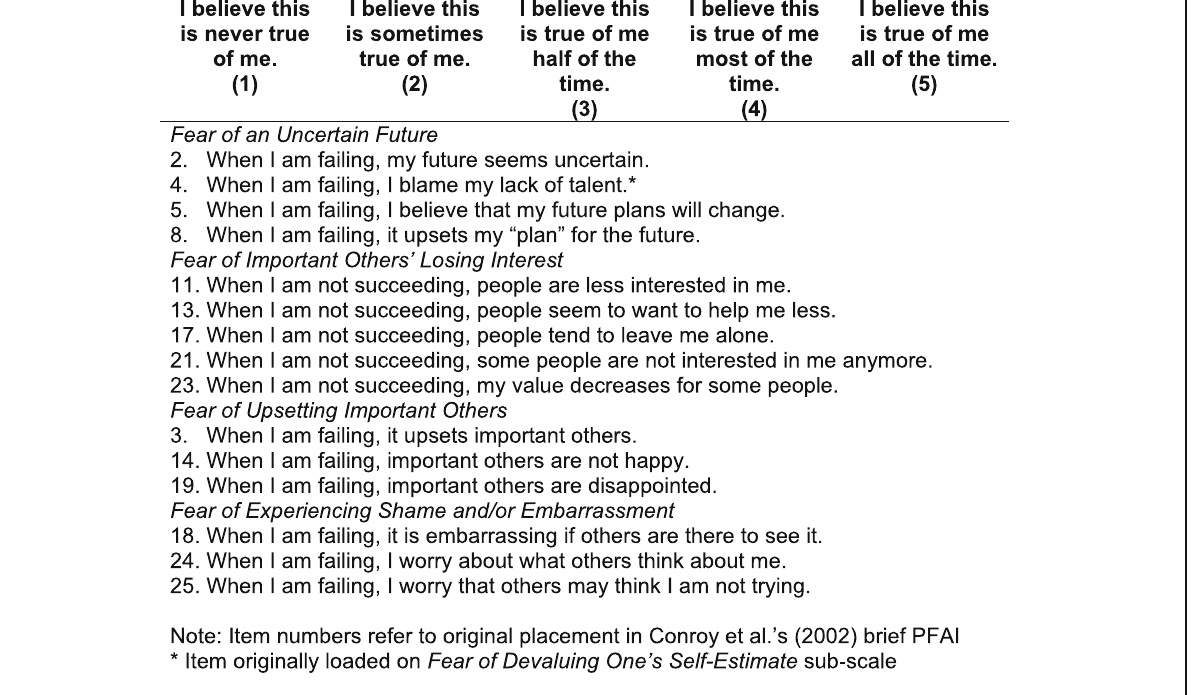
Fig. 3 Modified version of the